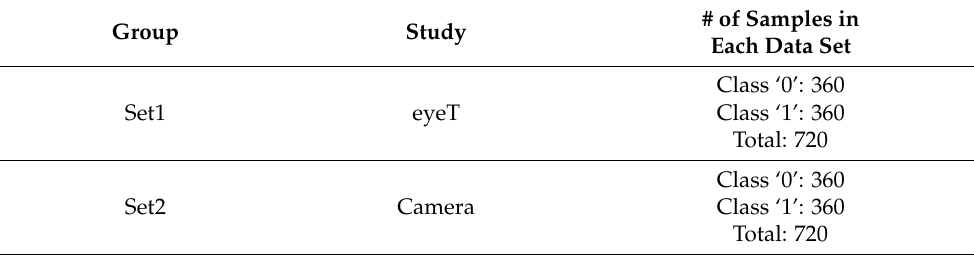
Table 2. Number of cases in eyeT and camera data.